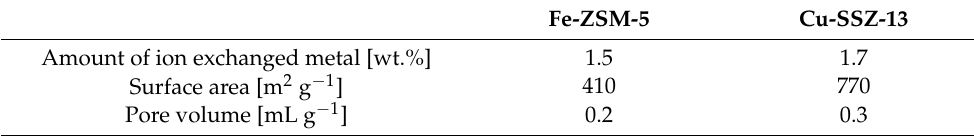
Table 3. Catalyst properties determined by elemental analysis (XRF) and N 2